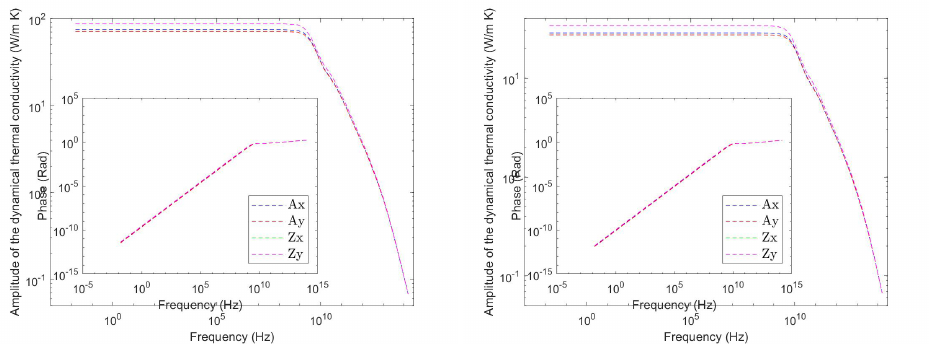
Figure 21. The amplitude and the phase of the dynamical thermal conductivity for GNRs, in the x- and y-direction. ( Left ): L y = 40 nm. ( Right ): L y = 15